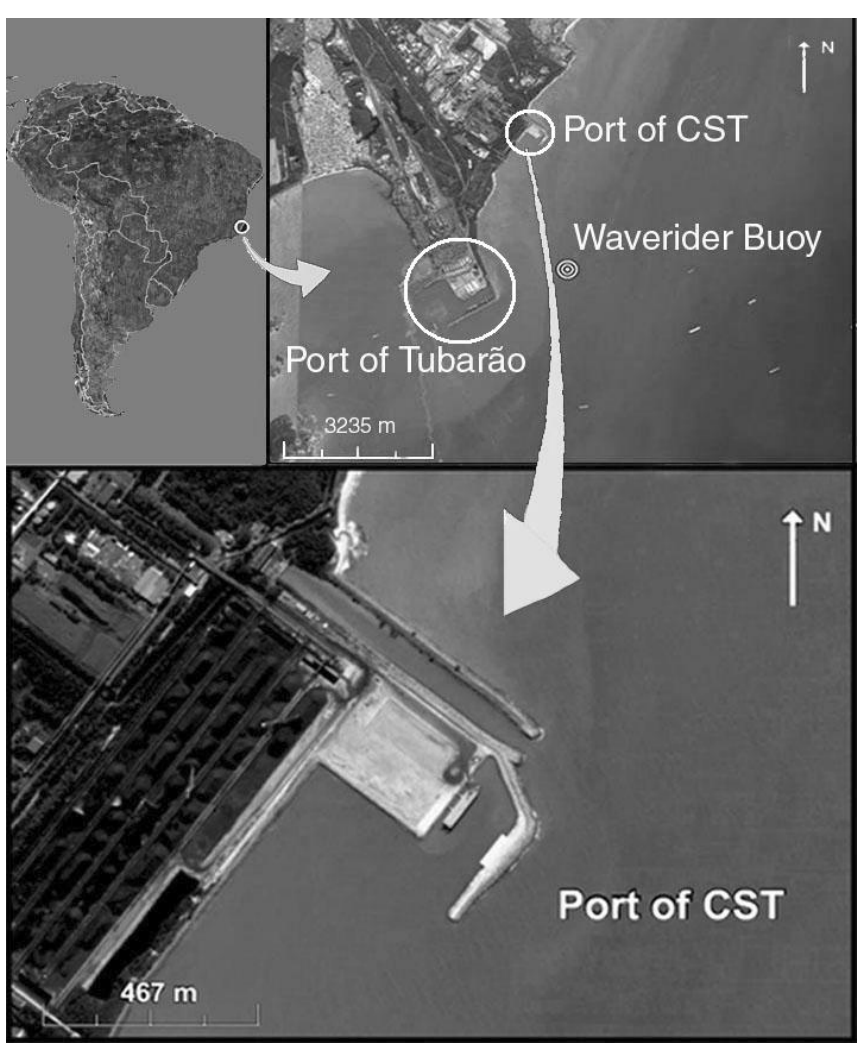
Fig. 1 – The study area, off of the city of Vitória, Espírito Santo State, Southeastern Brazil. The Waverider buoy position is also shown, together with the Port of CST and the Port of Tubarão. Source: Google